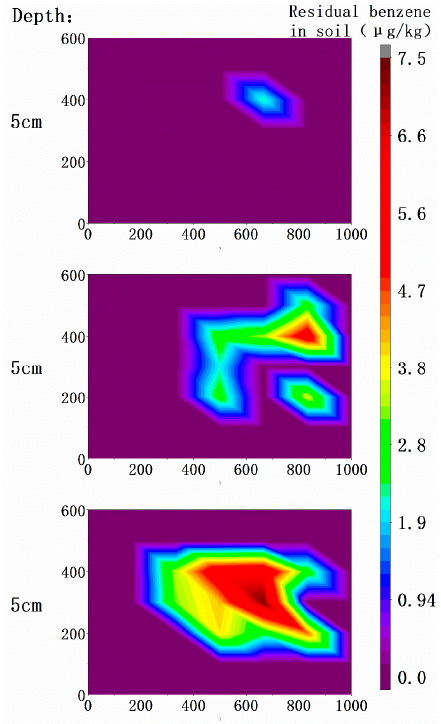
Figure 6. Distribution map of residual benzene in soil.